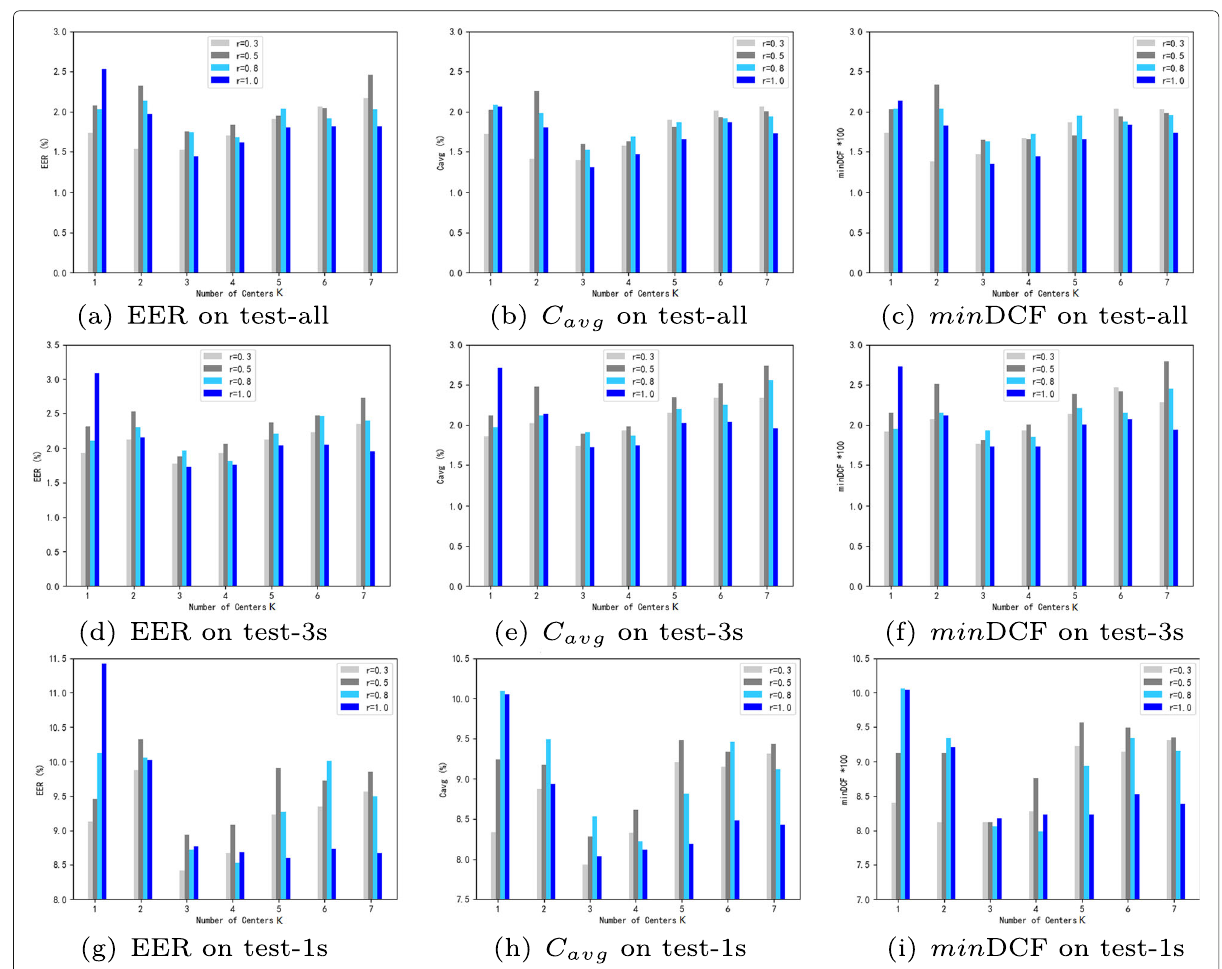
Fig. 3 Experimental results with different numbers of centers ( K ) under four different scale factors ( r